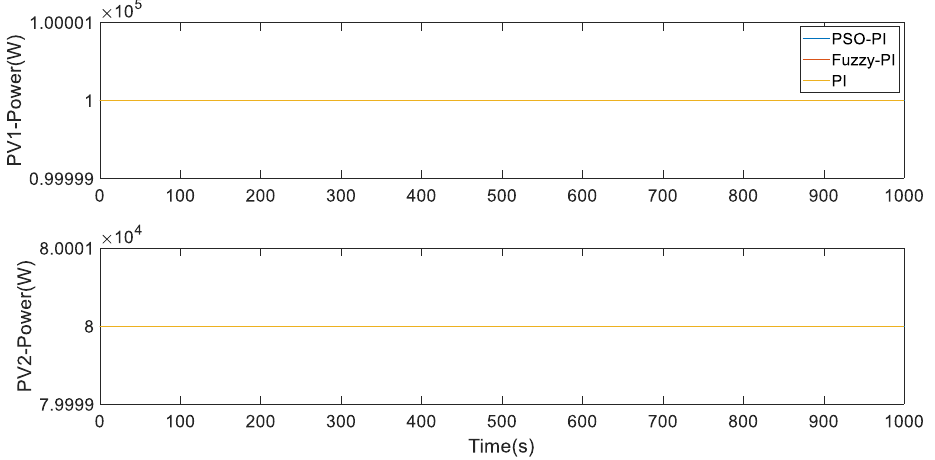
Figure 35. Output power of photovoltaic power generation unit when one generator fails.